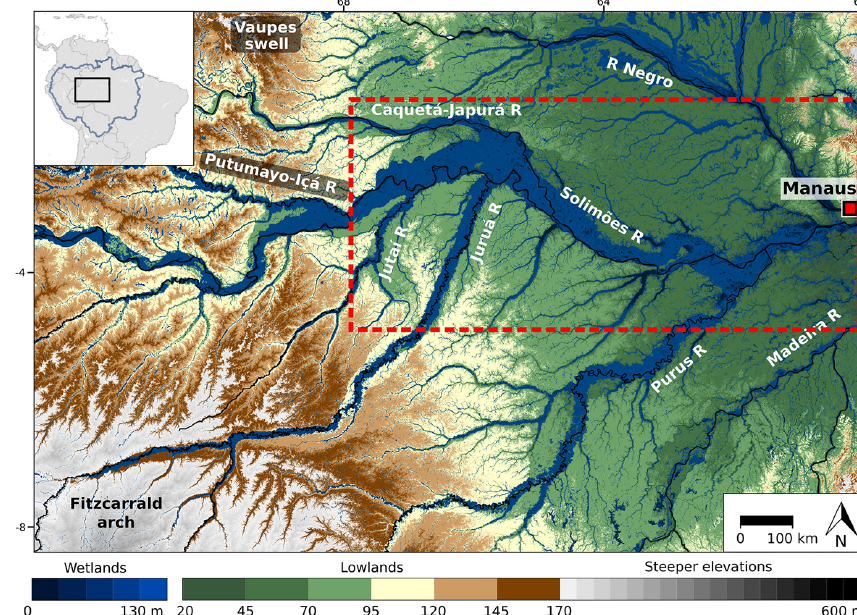
Figure 1. Topography of central Amazonia with key geographical designations such as cities, rivers and geological and geomorphic features including terrace levels (lowlands), floodplains (wetlands) and drainage network. The red square illustrates the location of the city of Manaus. Dotted red rectangle represents the region that is reproduced in the model and that represents the model grid. This illustration is based on a digital elevation model from the Shuttle Radar Topography Mission